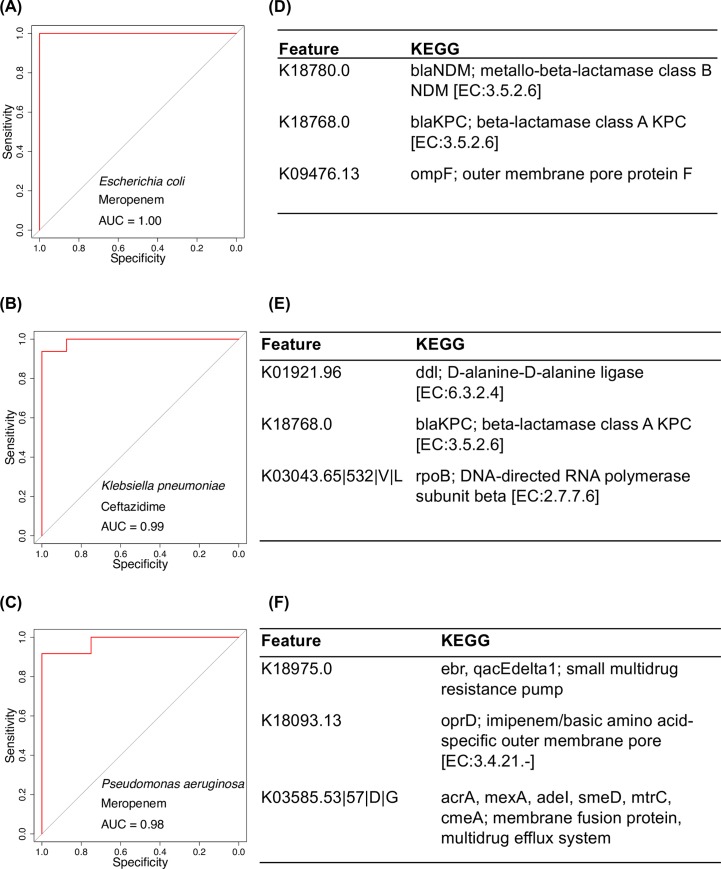
Validation performance metrics using an external dataset.AUROC (Area under the Receiver Operating Characteristic) for the prediction of the external dataset and top three predictors (KEGG orthlog variants based on importance) from the prediction models are reported. A) The AUROC curve for the E. coli and meropenem; B) The AUROC curve for the K. pneumoniae and ceftazidime; C) The AUROC curve for the P. aeruginosa and meropenem; D) The top three predictors for the E. coli and meropenem; E) The top three predictors for the K. pneumoniae and ceftazidime; F) The top three predictors for the P. aeruginosa and meropenem.